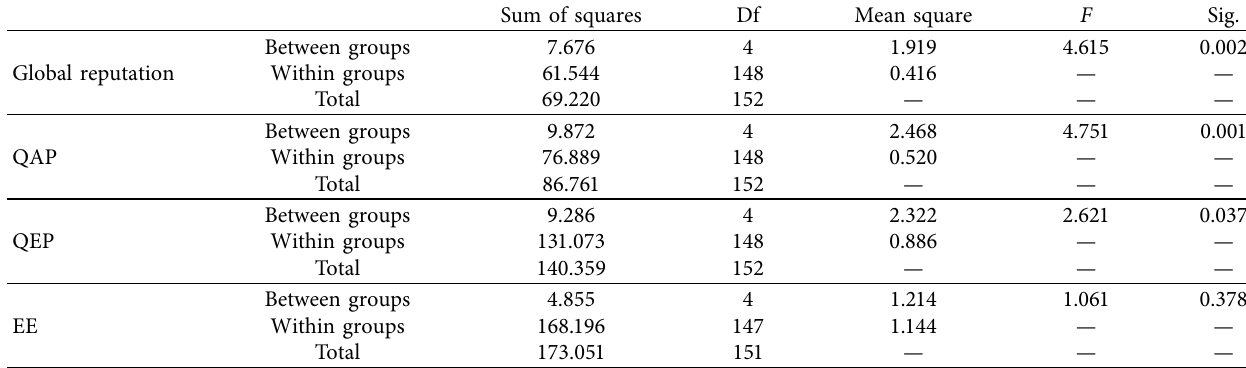
Table 7: ANOVA (stream-field-based). Sum of squares